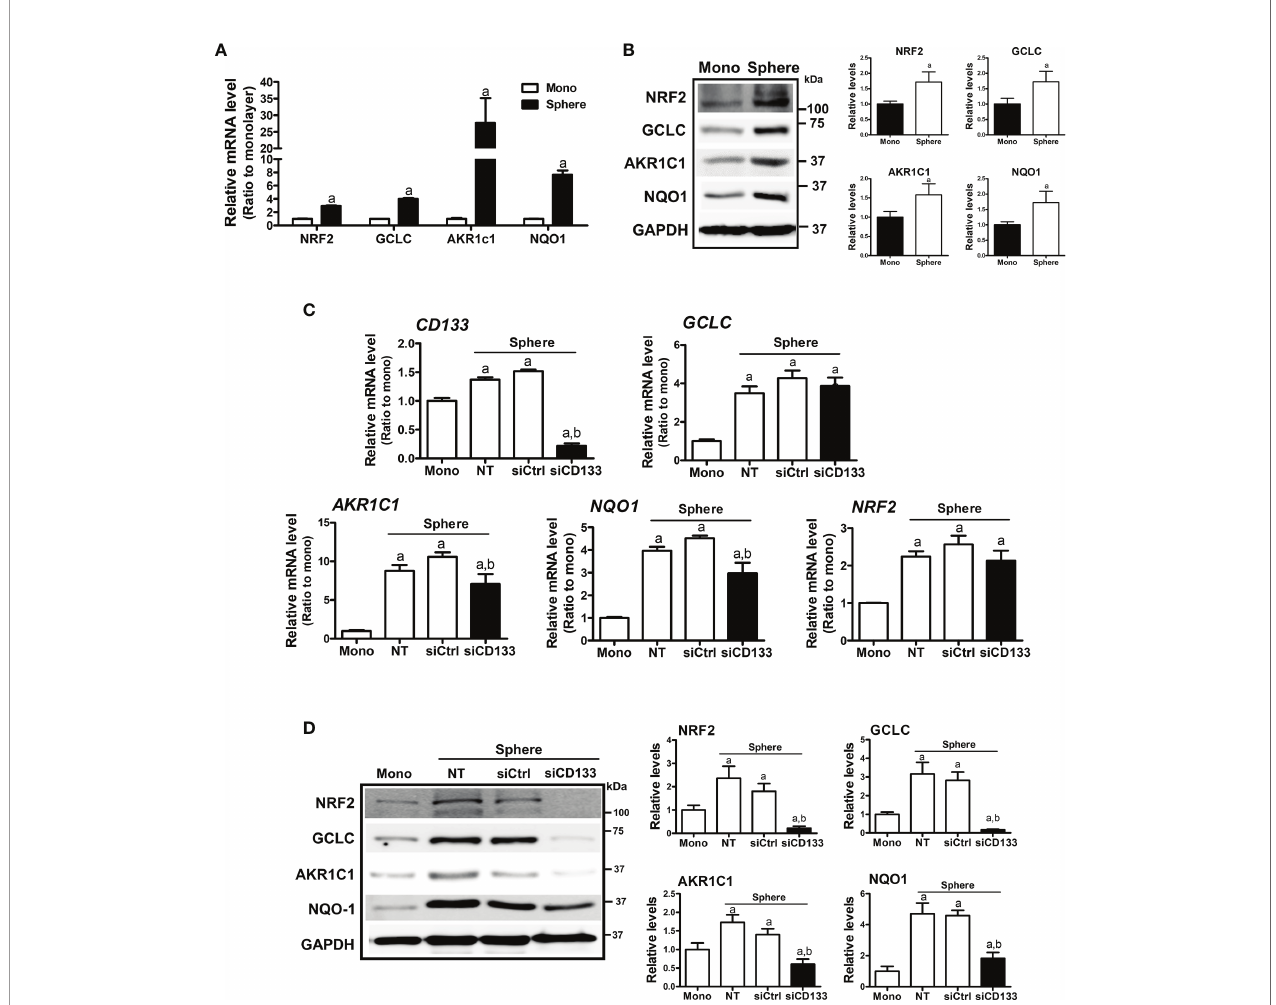
FIGURE 2 | Association of CD133 with NRF2 upregulation in HCT116 spheres. (A) Transcript levels of NRF2 , GCLC , AKR1C1 , and NQO1 were measured in monolayer and sphere HCT116 cells using a relative qRT-PCR analysis. a P < 0.05 compared with the monolayer group. (B) Protein levels of NRF2, GCLC, AKR1C1 and NQO1 were assessed in monolayer and sphere HCT116 cells. Bar graph represents quanti fi ed protein levels from at least three experiments. a P < 0.05 compared with the monolayer group. (C) HCT116 with either the non-transfection (NT), non-speci fi c siRNA (siCtrl) or CD133-speci fi c siRNA (siCD133) transfection were grown in the sphere culture system, and transcript levels of CD133 , GCLC , AKR1C1 , NQO1 , and NRF2 were measured. a P < 0.05 compared with the monolayer. b P < 0.05 compared with the siCtrl group. (D) Protein levels for NRF2, GCLC, AKR1C1, and NQO1 were monitored in sphere cultured HCT116 cells with either the non-speci fi c siRNA (siCtrl) or CD133-speci fi c siRNA (siCD133) transfection. Bar graph represents quanti fi ed protein levels from at least three experiments. Quanti fi cation results of western blotting were relative values to the loading control GAPDH. a P < 0.05 compared with the monolayer. b P < 0.05 compared with the siCtrl group. NT, non-transfection